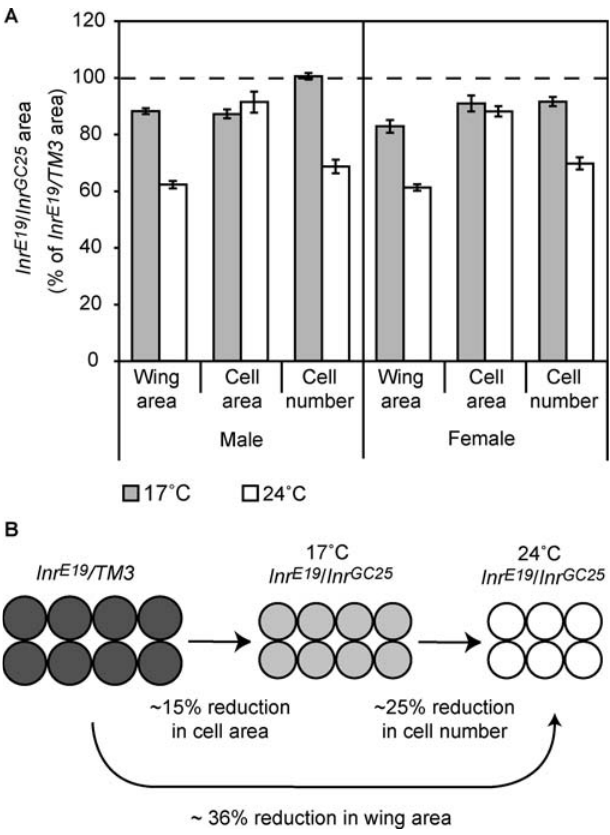
Figure 6. A Reduction in Inr Activity Affects Cell Size and Cell Number Independently (A) At 17 8 C, the difference in wing area between Inr E19 /Inr GC25 and Inr E19 /TM3 flies is due to a difference in cell size, whereas at 24 8 C the difference is due to an additional difference in cell number. Bars show wing area, cell area, and cell number in Inr E19 / Inr GC25 flies as a percentage of area or number in Inr E19 /TM3 flies. (B) At 17 8 C the reduced Inr activity in Inr E19 /Inr GC25 flies reduces cell area to approximately 85% the area in Inr E19 /TM3 flies, whereas at 24 8 C there is no further reduction in cell area, but there is a reduction in cell number to approximately 75% of the number in Inr E19 /TM3 flies. Mean wing and cell area, and cell number are given in Table